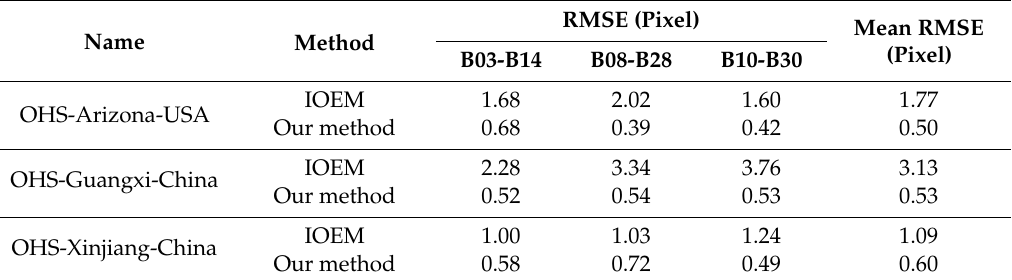
Table 3. Registration accuracy between non-adjacent